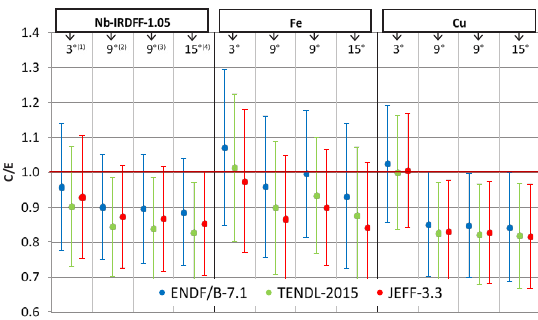
Figure 5. C / E values of the BWR dosimeter specific activities.